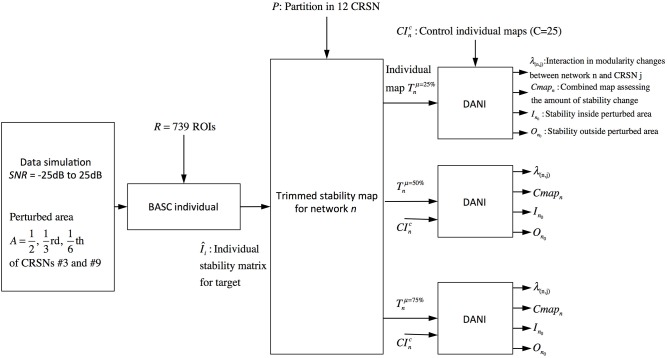
Pipeline summarizing the validation procedure: the input is the preprocessed fMRI data perturbed within a region of size A (A = 1/2, 1/3, and 1/6 of the targeted networks) at a specific SNRdB and the outputs are the metrics Cmapn, λn,j, In0 and On0. Simulations were performed considering 3 core sizes (μ = 25, 50, and 75%) for the estimation of the trimmed stability maps.